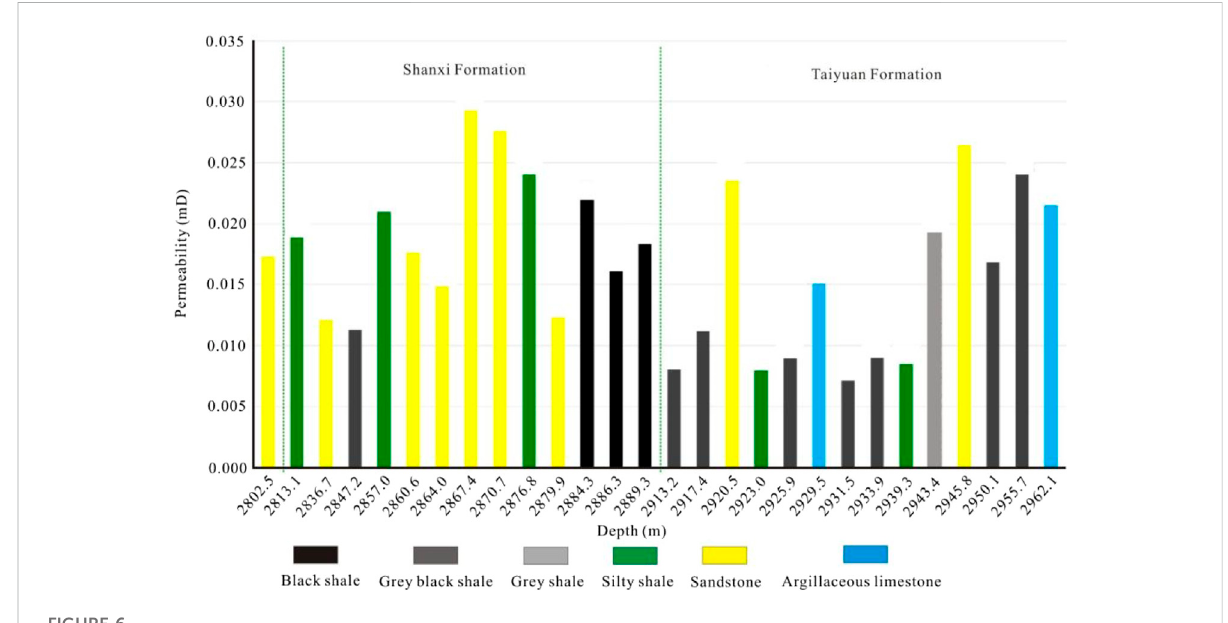
FIGURE 6 Histogram of permeability distribution of rock samples from Well MY1.